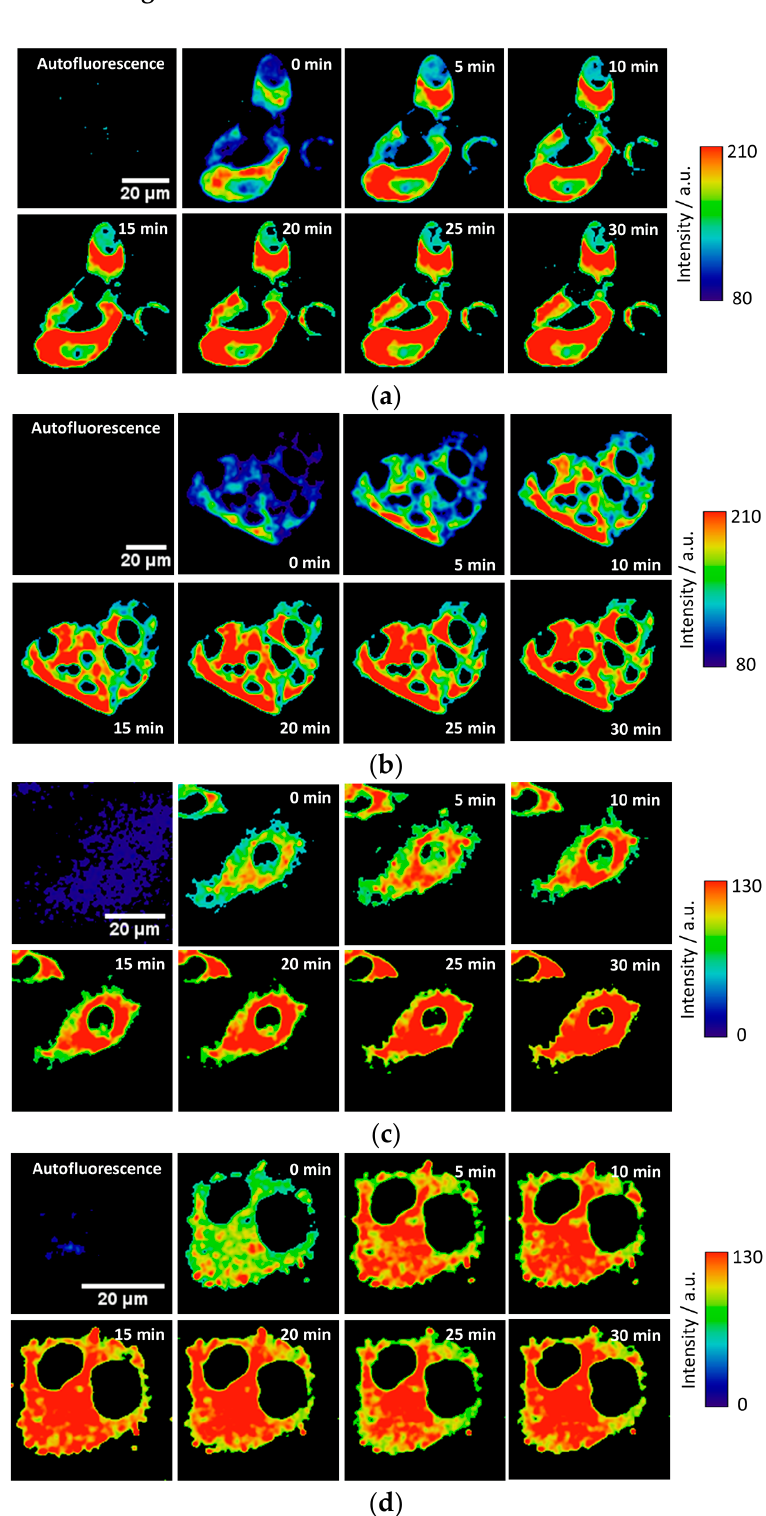
Figure A1. Other representative examples of the fluorogenic reaction of DNBS-2Me-4OMe-TM (6 × 10 − 7 M) in response to intracellular biothiols in ( a , b ) Hep2G and ( c , d ) MC3T3-E1 cells. Only pixels in the cytoplasm are shown.